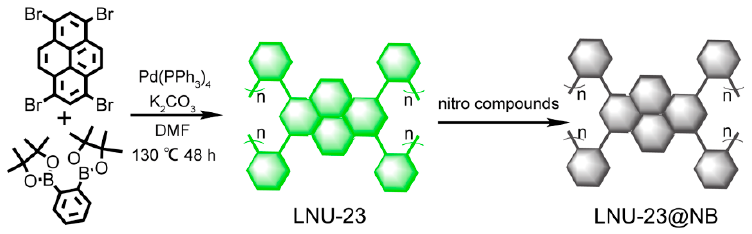
Figure 1. Synthesis and schematic structure of LNU-23. LNU-23 is composed of benzene rings and pyrene building blocks connected by carbon–carbon bonds. During this process, the irreversible coupling reaction tends to form defects in the architecture leading to the formation of an amorphous porous network of